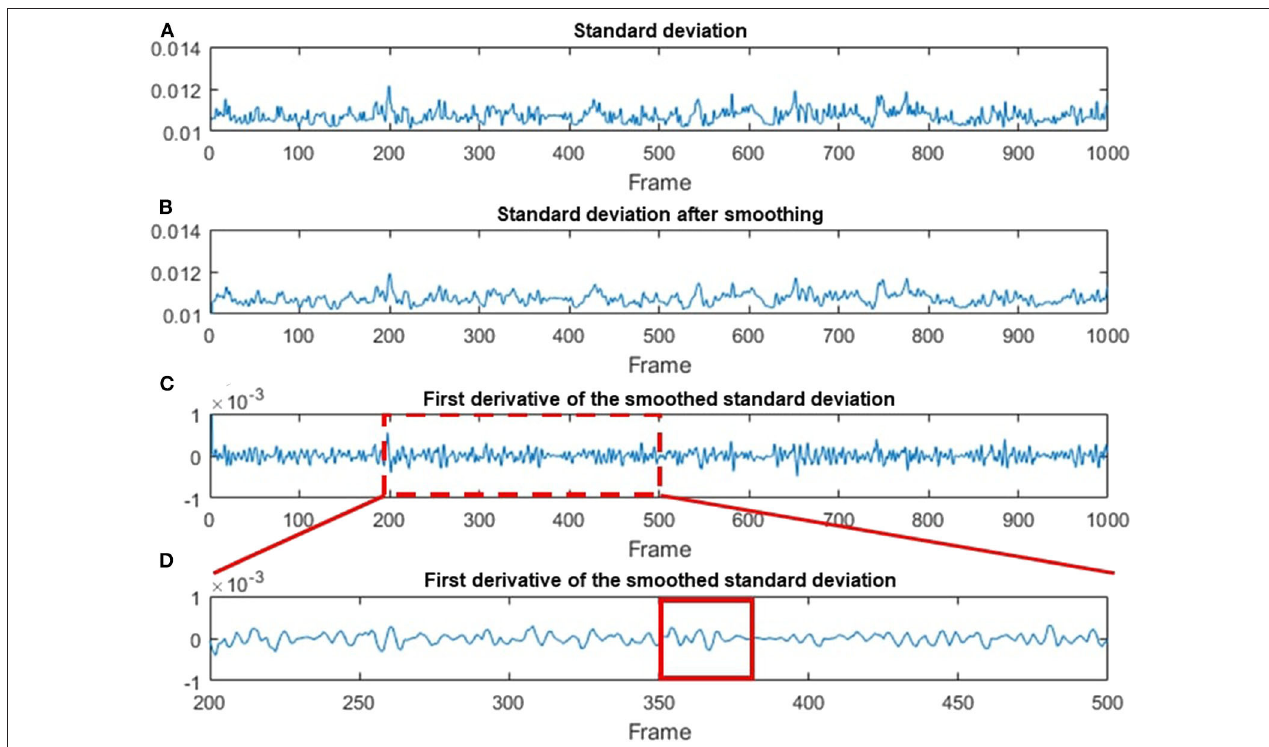
FIGURE 7 | Data processing steps based on the STD method. (A) The original STD-processed data as a function of the frame number. (B) The smoothing-processed plot of (A) . (C) The first deviation of the smoothed data in (B) . (D) A magnified plot of a section in (C) , where multiple chewing cycle can be clearly seen. A red solid line box is used to indicate one of the chewing